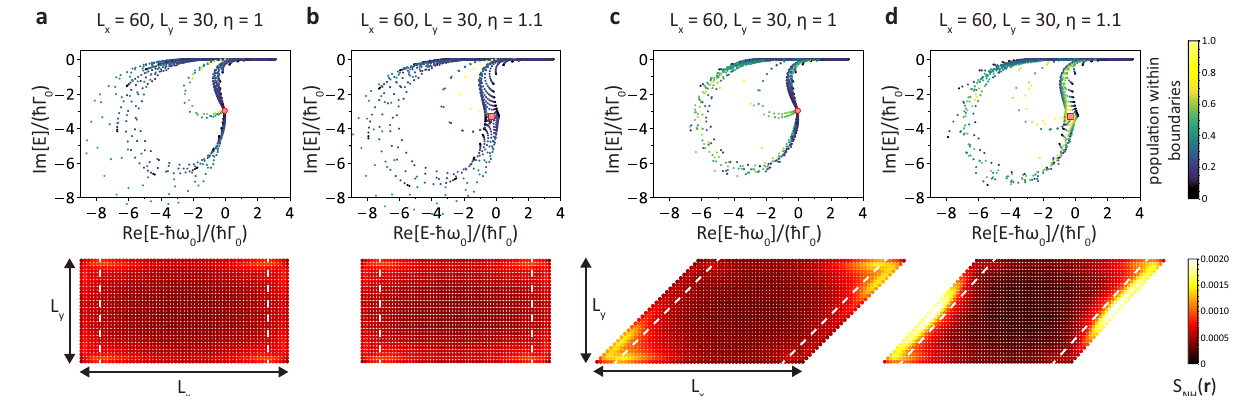
Fig. 4 | Geometry-dependent non-Hermitian skin effect in rectangle and geometries suppress NHSE. Each mode is colored according to its population parallelogram-shaped boundaries. Spectra and spatial distribution of non- within the given boundaries (out of white dashed lines, leftmost and rightmost 6 sites), and those extensive skin modes in ( d ) are located around the exceptional Hermitianrighteigenstatesof2Dsquare( a , c )andrectangular( b , d )atomiclattices points in the corresponding bulk spectra. In all the spectra, the nondefective ( a =0.2 λ ) with rectangle ( a , b ) and parallelogram ( c , d ) shaped boundaries. At a fi xed system size L degeneracy points and exceptional points are denoted by the red circles and red x × L y =60×30,only the geometry in ( d ) exhibits extensive skin rectangles, modes localized at left and right boundaries since mirror symmetries of the other